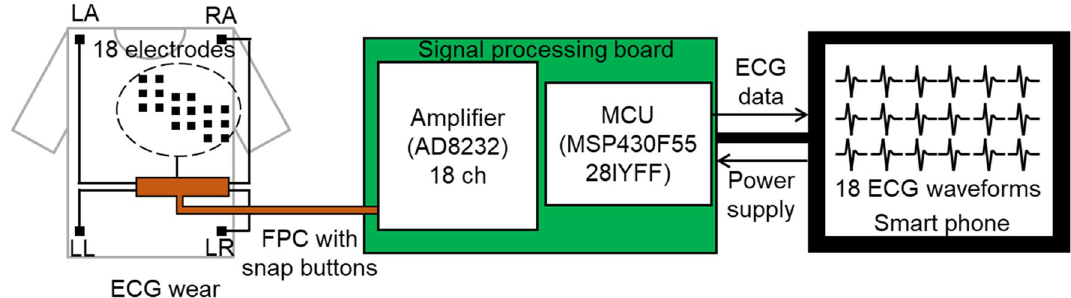
Figure 6. Wearable multi-lead ECG measurement device and data acquisition